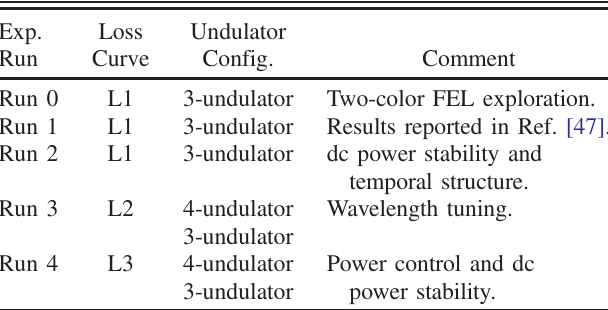
TABLE I. The study of two-color FEL lasing is conducted using five experimental runs (Exp. Run) with various undulator configurations (Undulator Config.) and different levels of cavity loss in a period of 25